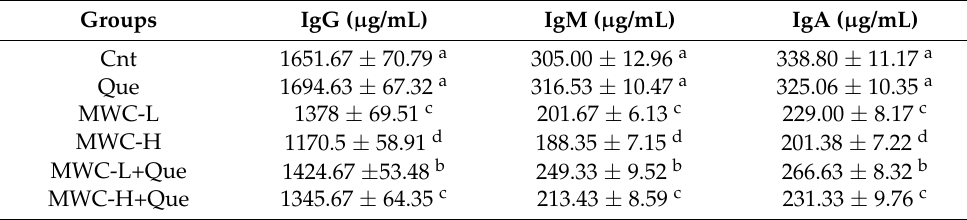
Table 4. The effect of MWCNTs and/or Que on serum levels of IgG, IgM, and